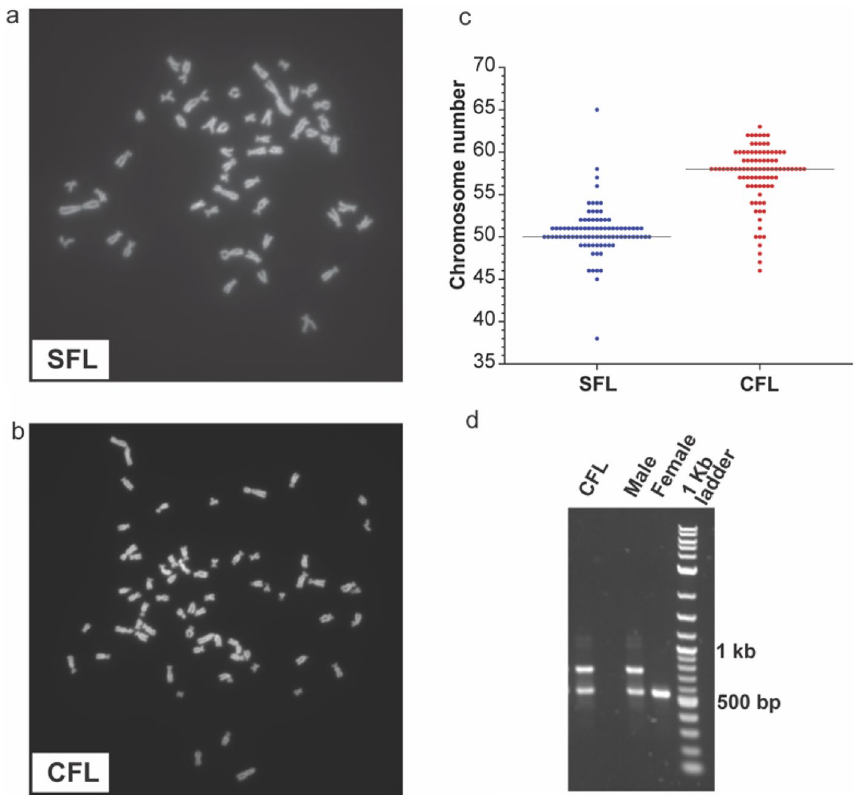
Figure 2. ( a ) Representative chromosome spread for SFL. ( b ) Representative chromosome spread for CFL. ( c ) The graph shows the chromosome counting for 88 and 92 spreads respectively for SFL and CFL. ( d ) Gel picture showing products obtained from PCR on genomic DNA using primers to determine sex in Pachón cavefish. Presence of the higher molecular weight band indicates the presence of a B chromosome, and the sex is determined as male.